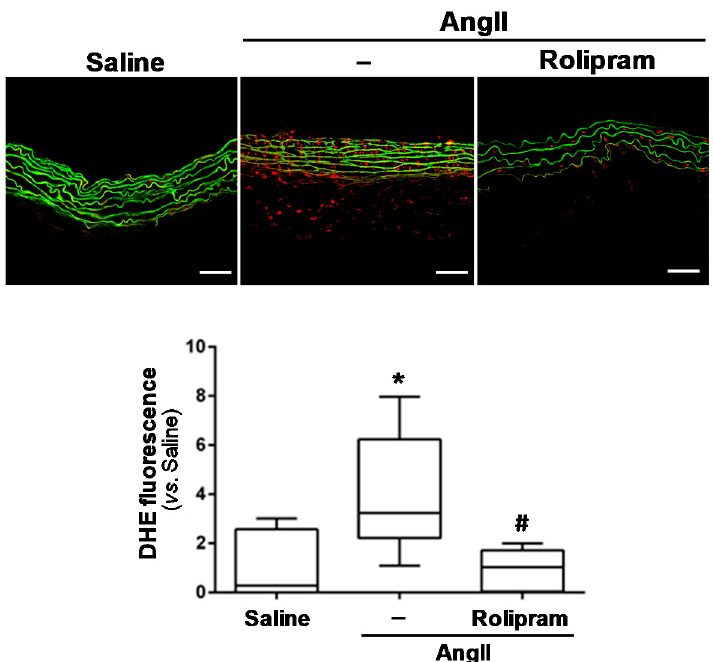
Figure 6. Rolipram reduces the increased production of vascular superoxide anions induced by AngII in ApoE − / − mice. The ApoE − / − mice were infused with saline solution or AngII (1000 ng/kg/min) for 28 days. The mice challenged with AngII were treated or not with rolipram (3 mg/kg/day). Their vascular superoxide anion production was assessed by DHE staining in the abdominal aorta sections of each experimental group. Representative images of the DHE staining are shown (Bars: 50 µ m). The data are presented as box and whisker plots. The box extends from the 25th to the 75th percentile, and median is indicated by a horizontal line. The whiskers represent the maximum and minimum values (saline-infused mice n = 6; AngII-challenged mice, n = 8; AngII-challenged mice treated with rolipram, n = 7). p < 0.01: * vs. saline-infused mice; # vs. AngII-challenged mice.